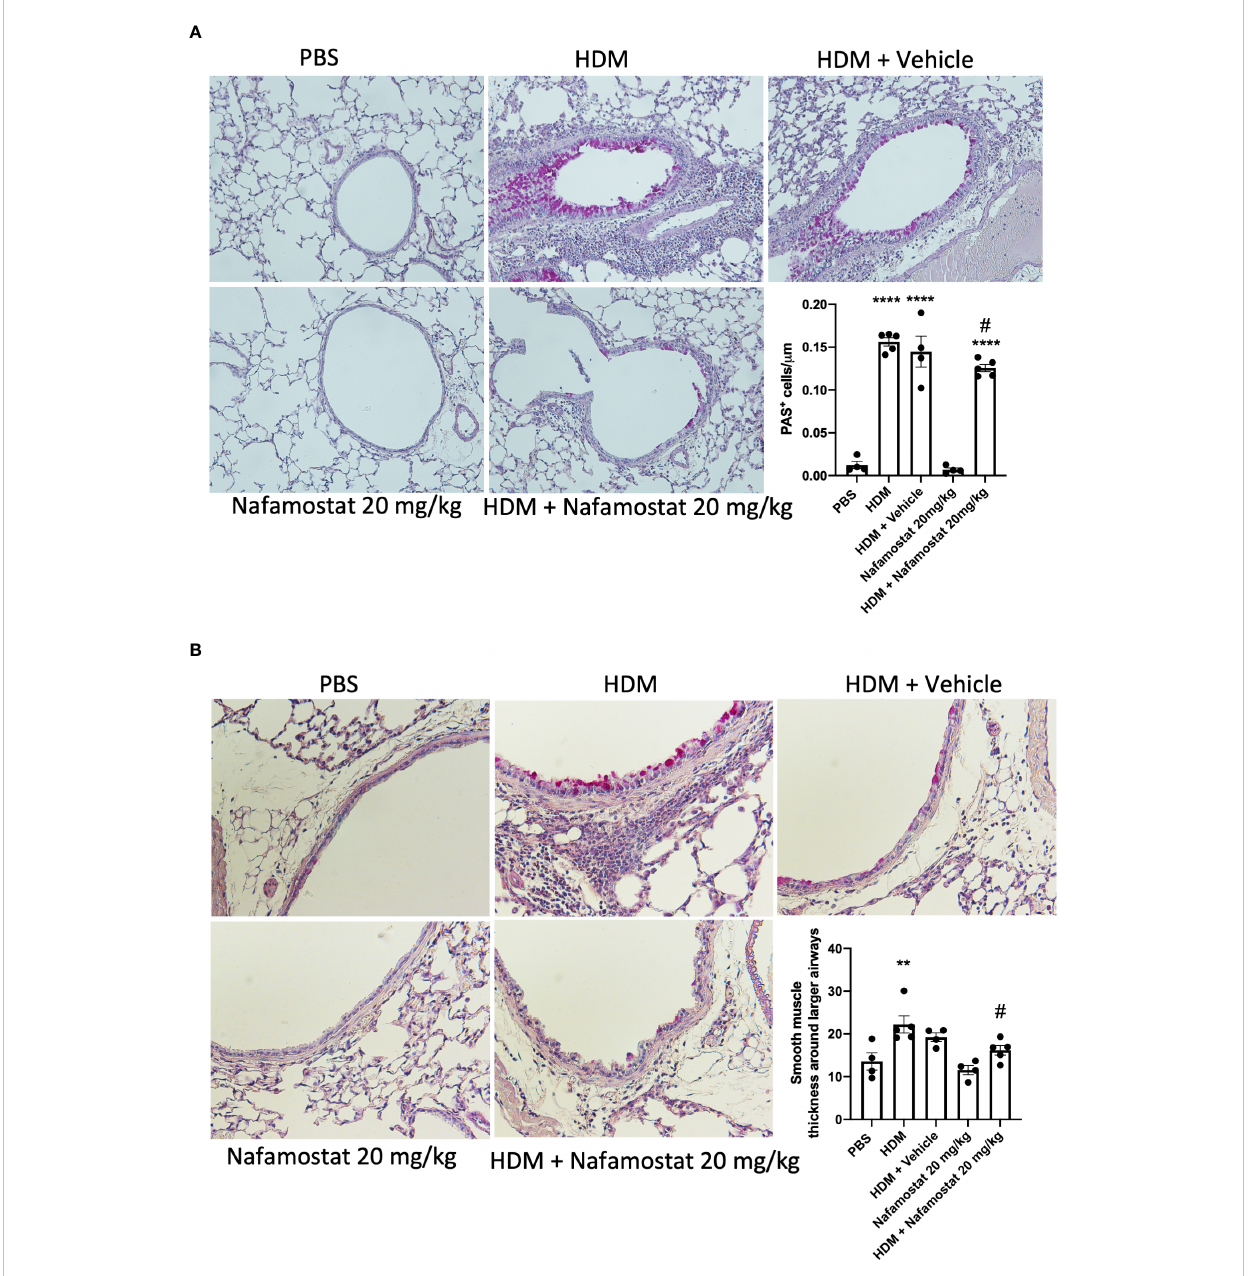
FIGURE 4 Effects of nafamostat on goblet cell hyperplasia and smooth muscle layer thickness in mice subjected to HDM-induced experimental asthma. Mice received either PBS or HDM extract twice a week for 6 weeks. Mice were treated with vehicle or with nafamostat (20 mg/kg) 30 min prior to each HDM extract instillation. Control mice were treated with PBS only. Goblet cell hyperplasia (A) and smooth muscle layer thickness around the primary bronchi (B) were quanti fi ed by Periodic Acid – Schiff (PAS) staining. Representative images for PAS staining (x 40 original magni fi cation) are shown. Data represent mean values ± SEM. ** P < 0.01, **** P < 0.0001 vs. the PBS group. # P < 0.05 vs. the HDM group. n = 4 – 5 mice per group. HDM, house dust